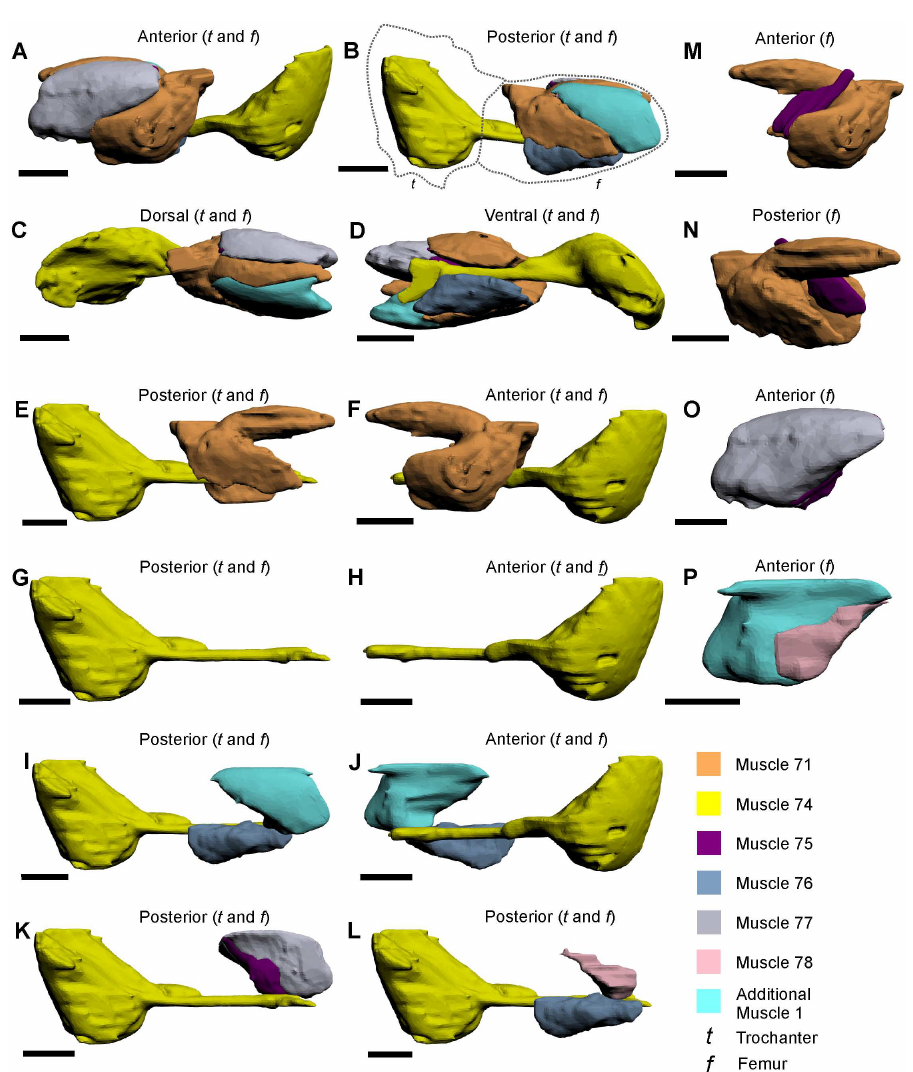
Fig 6. The muscles within the trochanter and femur of the walking legs, male pedipalp and pushing leg, as modelled from iodine staining and micro-CT–scanning. The illustrated muscle reconstructions were selected from the male pedipalp 3D PDF (S4 Fig), as these reconstructions are the most anatomically informative. A–D depict the seven femoral muscles and their relative positions to each other. The individual muscles (E–P) are shown in anterior and posterior views to accurately display the main features, shapes and, where possible, their position relative to adjacent muscles. The dotted lines in B outline the trochanter and femur. All scale bars 5